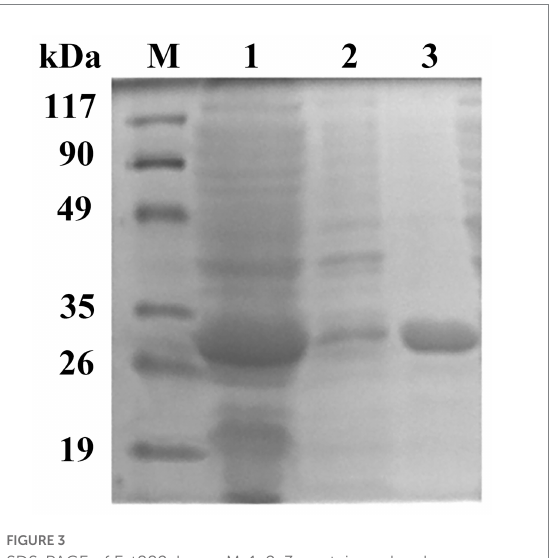
FIGURE 3 SDS-PAGE of Est882. Lanes M, 1, 2, 3: protein molecular mass marker. Cell lysate. Cell lysate supernatant. and purified Est882, respectively.